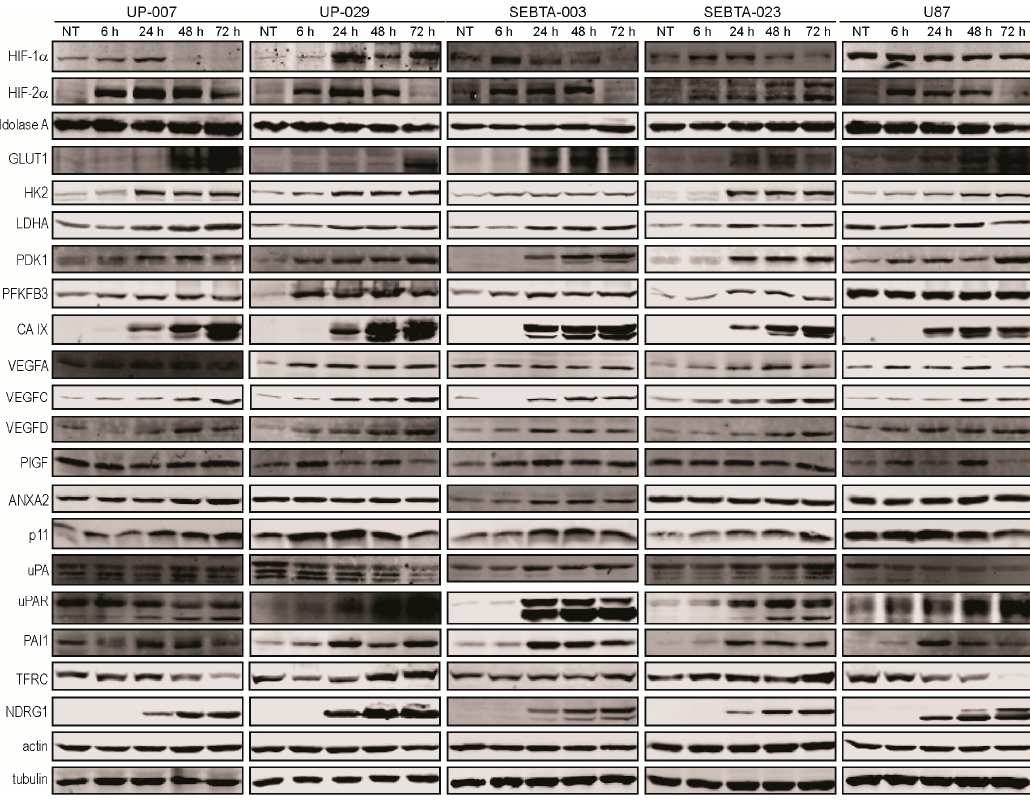
Figure 7. Analysis of hypoxia related proteins in GB cells. UP ‐ 007; UP ‐ 029; SEBTA ‐ 003; SEBTA ‐ 023 or U87 cells were incubated under normoxia (21% O 2 ) or hypoxia (1% O 2 ) for the times indicated. Cells were lysed and 20 μ g of each protein extract was subjected to SDS ‐ PAGE, and analyzed by Western blotting with the antibodies indicated. NT ‐ non treated/ normoxia.